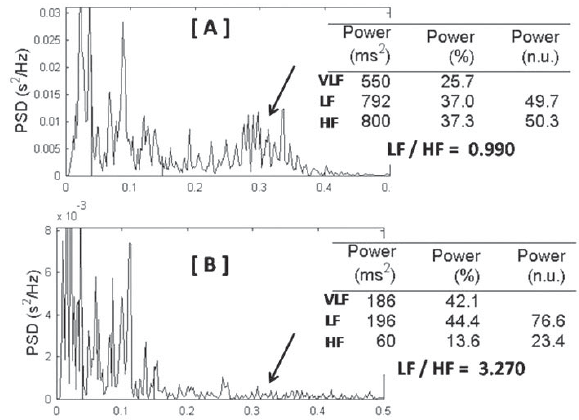
Fig. 3 – Análise espectral de frequências (Fast Fourier Transform) de um adulto jovem normal (A) e de um recém-nascido normal (B). O componente de alta frequência (HF) está proporcionalmente bem mais reduzido no recém-nascido (setas) assim como a potência